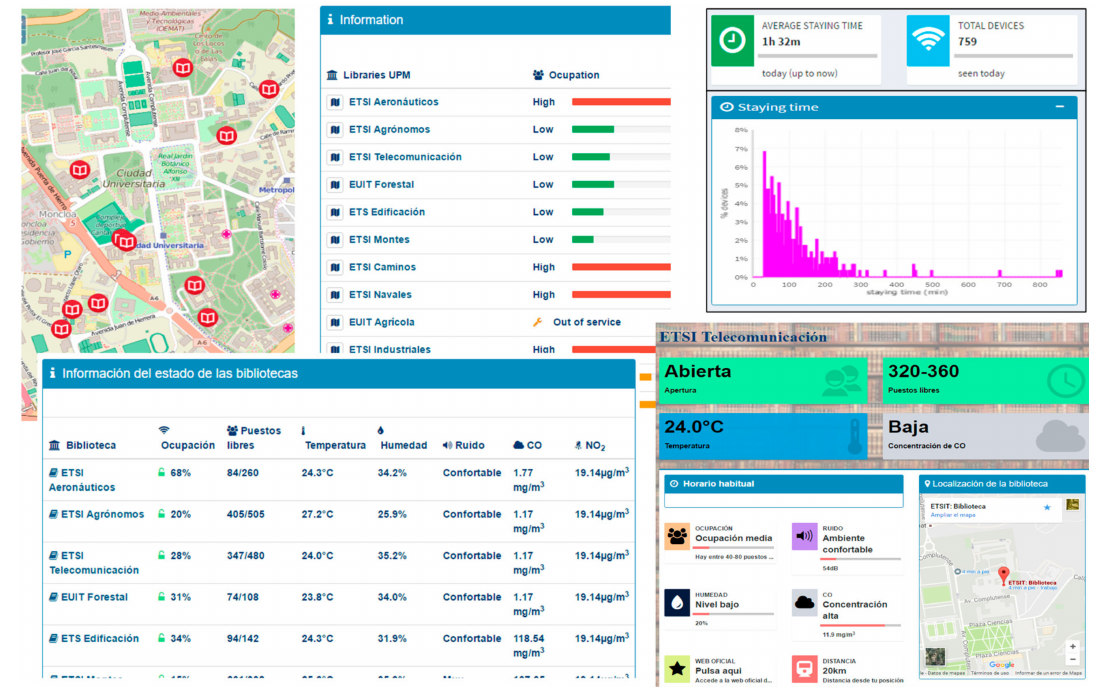
Figure 18. Web-based application to aid library